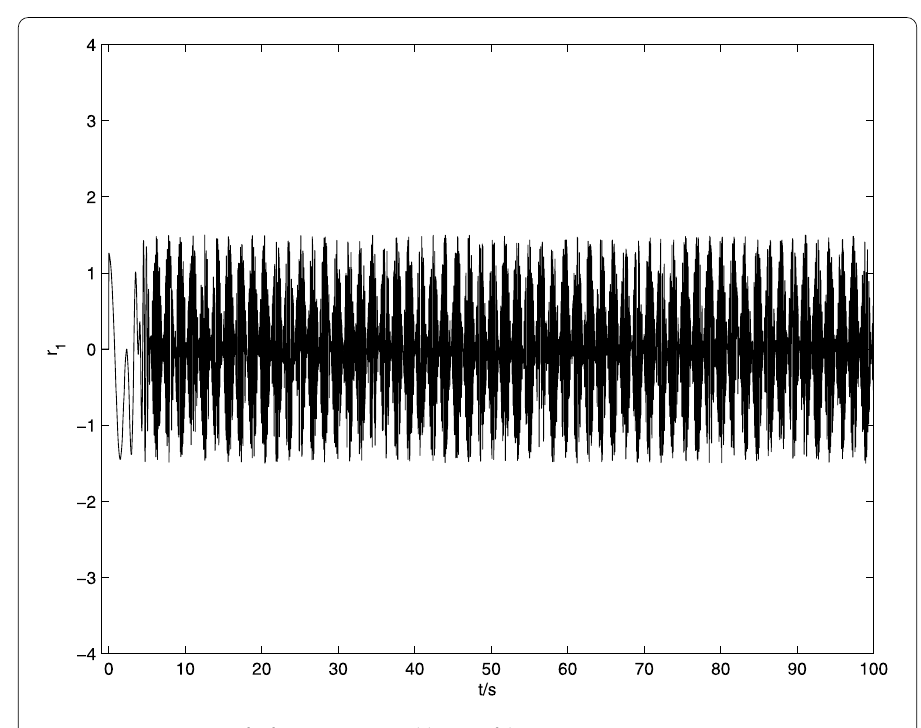
Figure 1 Time response of reference input variable r 1 ( t ) of the Lurie system